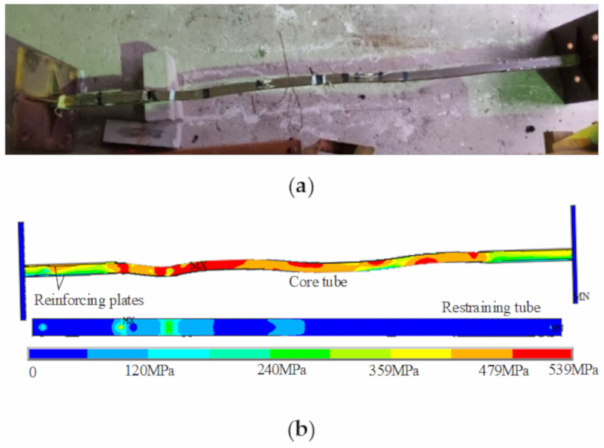
Figure 12. Comparison of failure mode: ( a ) Experimental result; ( b ) FE analysis